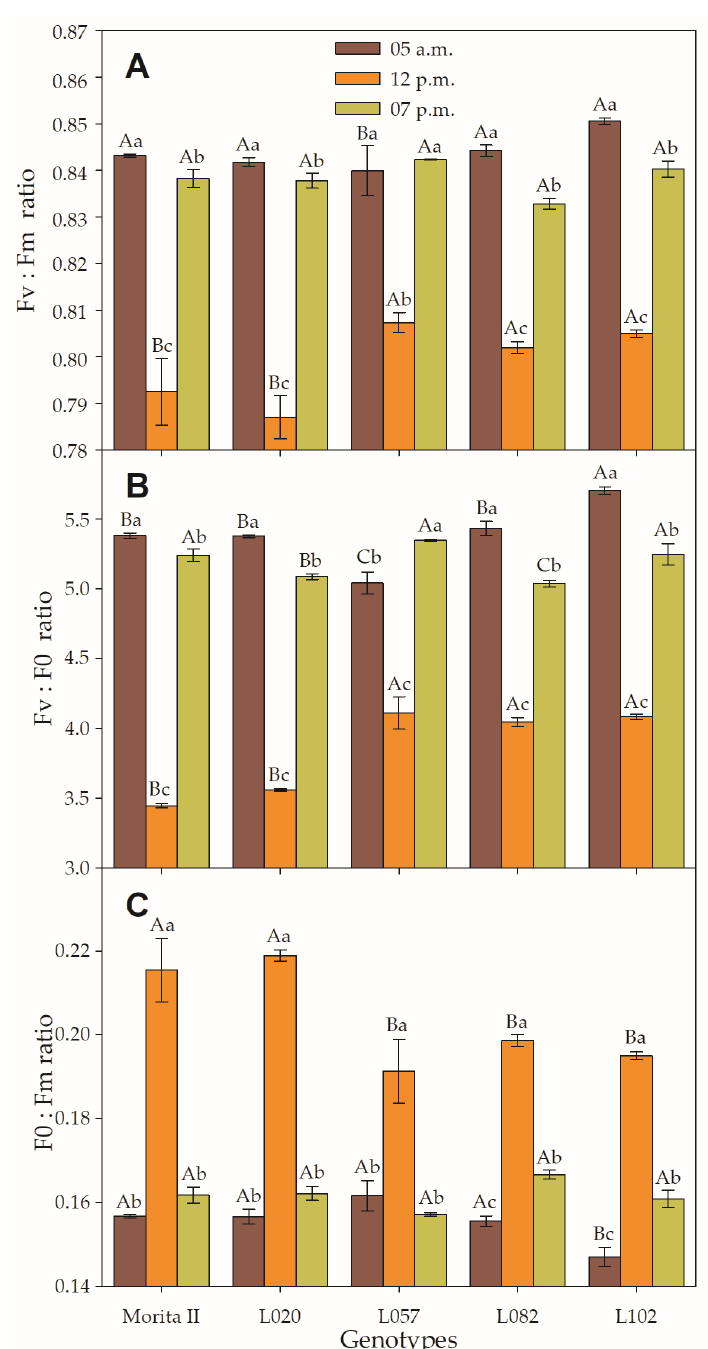
Figure 4. ( A ) Variable-to-maximum (Fv:Fm ratio), ( B ) variable to minimum (Fv:F0 ratio), and ( C ) minimum to maximum (F0:Fm ratio) chlorophyll fluorescence evaluated in genotypes of Stevia rebaudiana (Morita II, L020, L057, L082, and L102) under land conditions in the complete absence of any plant stress. Means followed by different capital letters denote statistical significance between genotypes in the same evaluated time and different small letters denote statistical difference between evaluated times in the same genotype. Means ± SD (n = 5).